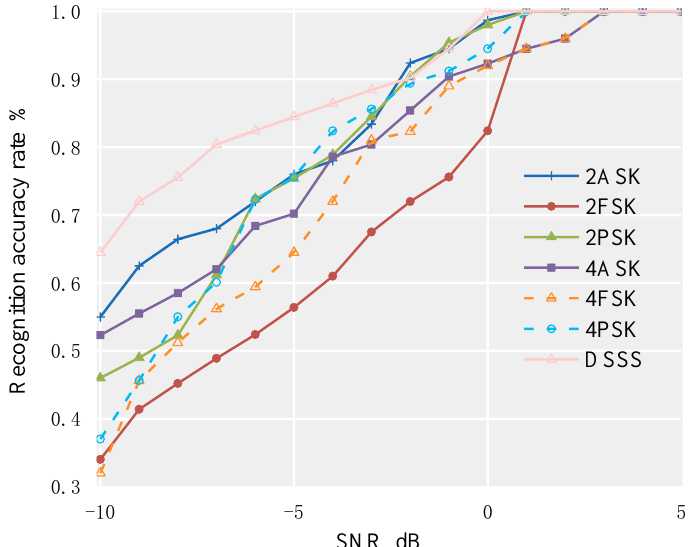
Figure 9. Accuracy of each signal identification under 2.5 km transmission superposition model of BELLHOP channel.